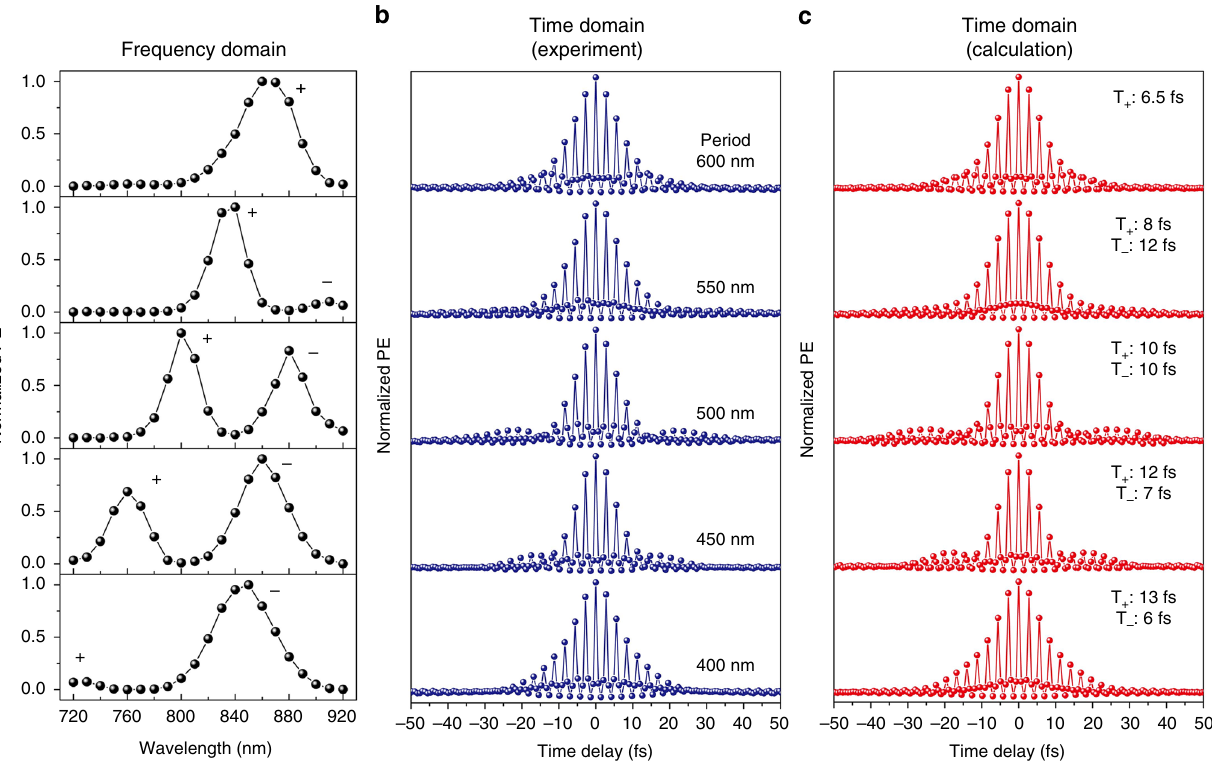
Fig. 5 Near- fi eld measurements in both the frequency and time domains. a Normalized photoemission (PE) intensity curves against the wavelength in the frequency domain. b Normalized PE intensity curves against the time delay in the time domain obtained by time-resolved photoemission electron microscopy (PEEM) measurements. c Calculated time-resolved PE signals with the best fi tted dephasing time. The nanoblock size is fi xed as 115 nm and the period is tuned from 400 to 600